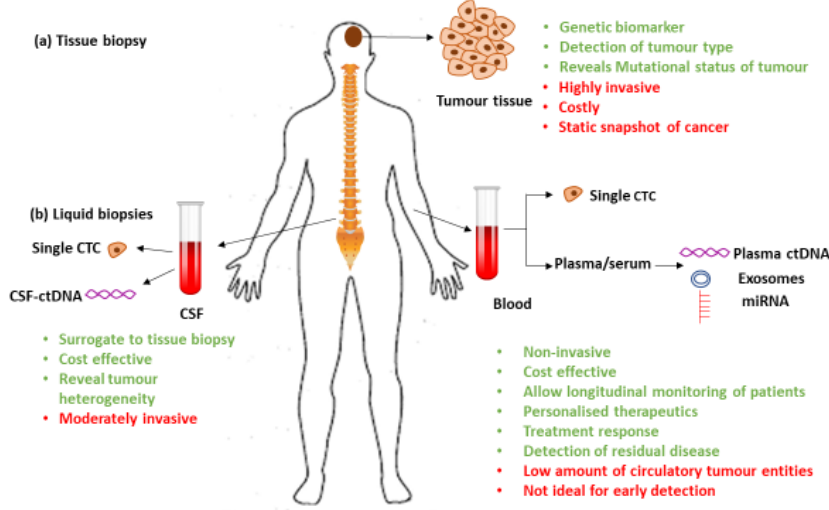
Figure 1. Comparison of tissue and liquid biopsies.